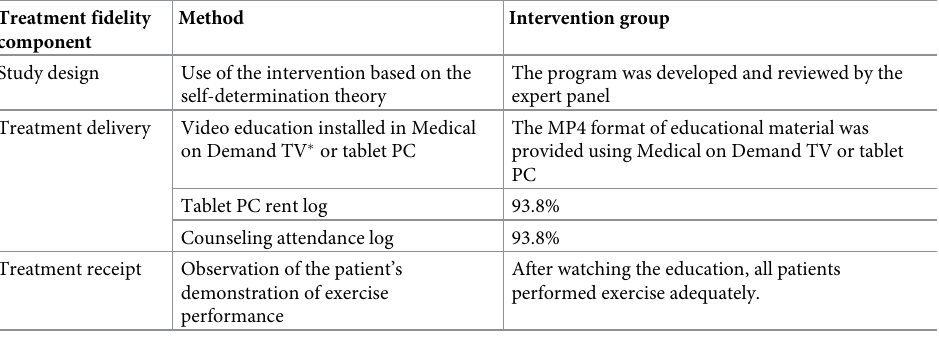
Table 4. Treatment fidelity assessment of the theory-based self-management